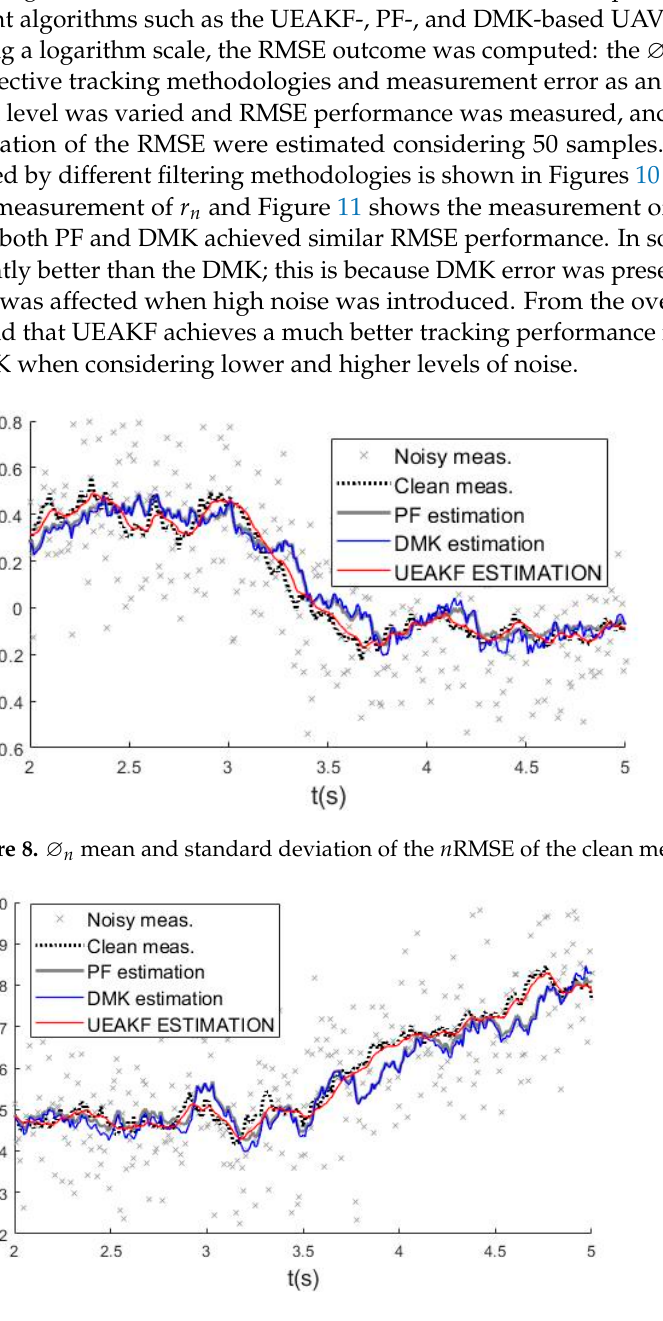
Figure 7. Flowchart for UAVs/drones position tracking.